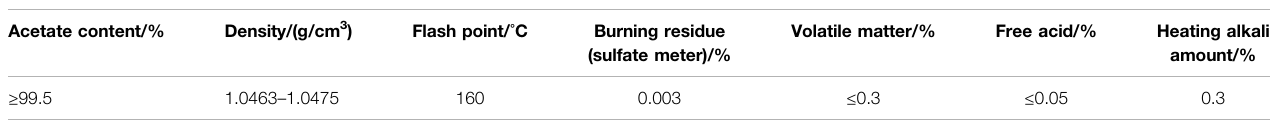
TABLE 5 | Physical indices of DBP.